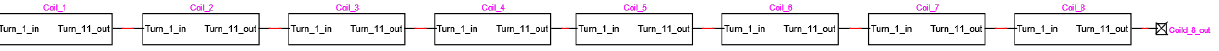
Figure 16. Phase model implemented in EMTP-RV; there are three identical phases and eight identical series coils per phase in the model.